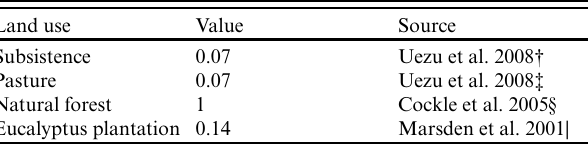
Table 4 . Species richness of forest-adapted birds as a proportion of that expected in a stand of high-quality Atlantic